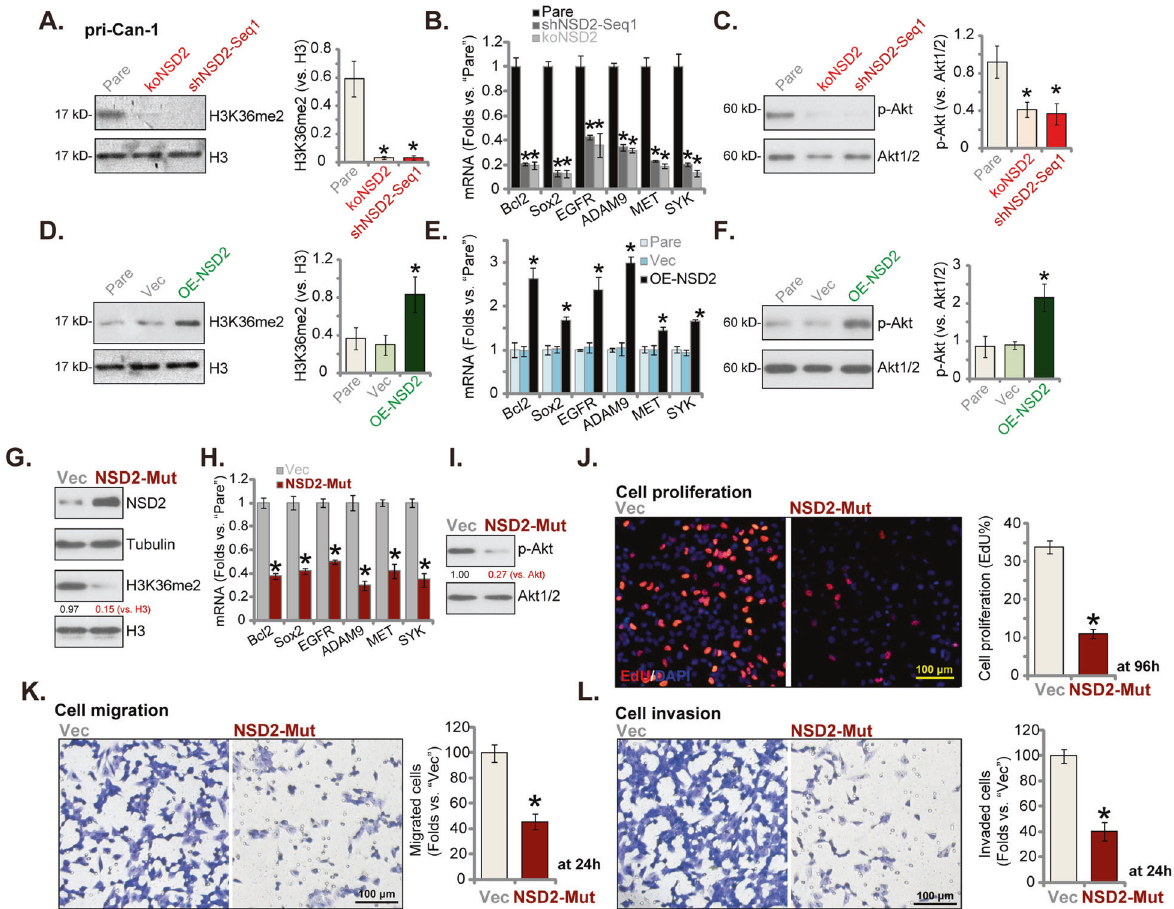
Fig. 6 H3K36 methylation, expression of multiple oncogenes, and Akt activation are decreased with NSD2 silencing or KO in CRC cells. Stable pri-Can-1 cells, expressing shNSD2-Seq1, a lentiviral CRISPR/Cas9-NSD2-knockout (KO) construct, a lentiviral construct encoding the full-length NSD2 cDNA ( “ OE-NSD2 ” ), or empty vector ( “ Vec ” ), were established and cultured. Expressions of listed proteins and mRNAs were tested by western blotting ( A , C , D , F ) and qRT-PCR assays ( B , E ), respectively. Stable pri-Can-1 cells with the lentiviral construct encoding the catalytic inactive NSD2 (Y1179A, “ NSD2-Mut ” ) or empty vector ( “ Vec ” ) were established. Expression of listed proteins ( G , I ) and mRNAs ( H ) were shown. Cells were further cultured for applied time periods, cell proliferation (EdU staining assays, J ), migration, and invasion ( “ Transwell assays ” , K , L ) were tested, with results quanti fi ed. “ Pare ” stands for the parental control cells. Data were presented as mean ±SD ( n = 5). * P < 0.05 vs. “ Pare ” / “ Vec ” cells. Experiments in this fi gure were repeated fi ve times and similar results were Here we found that levels of H3K36me2 and expressions of NSD2-associated oncogenic genes, ADAM9 , EGFR , Sox2 , Bcl-2 , SYK , and MET , were largely inhibited after NSD2 silencing or KO in CRC cells. Their levels were however increased with ectopic NSD2 overexpression. Furthermore, H3K36me2 and expressions of the oncogenic genes were decreased in NSD2 shRNA AAV-injected xenograft tissues. These results implied that NSD2-mediated H3K36me2 should be important for transcription activation and expression of multiple oncogenes in CRC. Due to mutations in different genes ( PTEN and PI3KCA , etc.) or constitutive activation of different receptor tyrosine kinases (RTKs) (i.e., epidermal growth factor receptor (EGFR), platelet-derived growth factor receptor, and fi broblast growth factor receptor), persistent activation of PI3K-Akt signaling is often detected in CRC [40 – 43], which is essential for cancer cell growth, proliferation, metastases, as well as metabolism reprogramming and apoptosis/ therapy resistances [44]. Recent studies have shown that NSD2 is important for Akt activation. For example, Li et al. [20] found that NSD2 transcriptionally increased expression of Rictor, a key component of mammalian target of rapamycin complex 2, to promote Akt Ser-473 phosphorylation and activation. Wang et al.